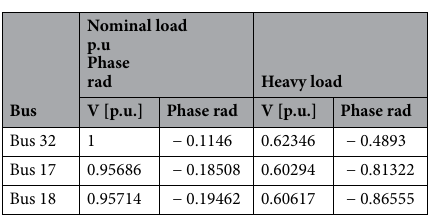
Table 3. Power flow results when adding SVC at bus